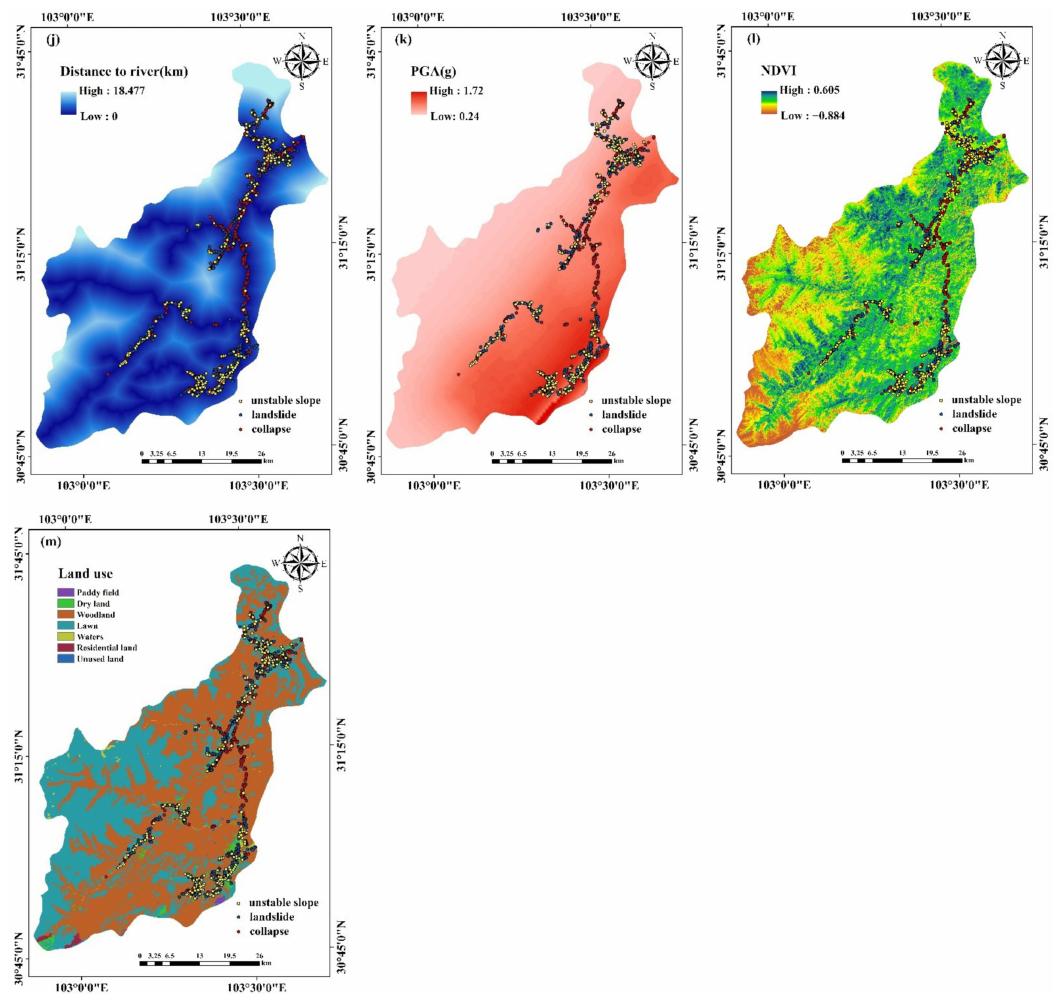
Figure 2. Schematic diagram of environmental factors: ( a ) slope, ( b ) aspect, ( c ) curvature, ( d ) terrain relief, ( e ) TWI, ( f ) lithology, ( g ) soil type, ( h ) distance to fault, ( i ) rainfall, ( j ) distance to river, ( k ) PGA, ( l ) NDVI, ( m ) land